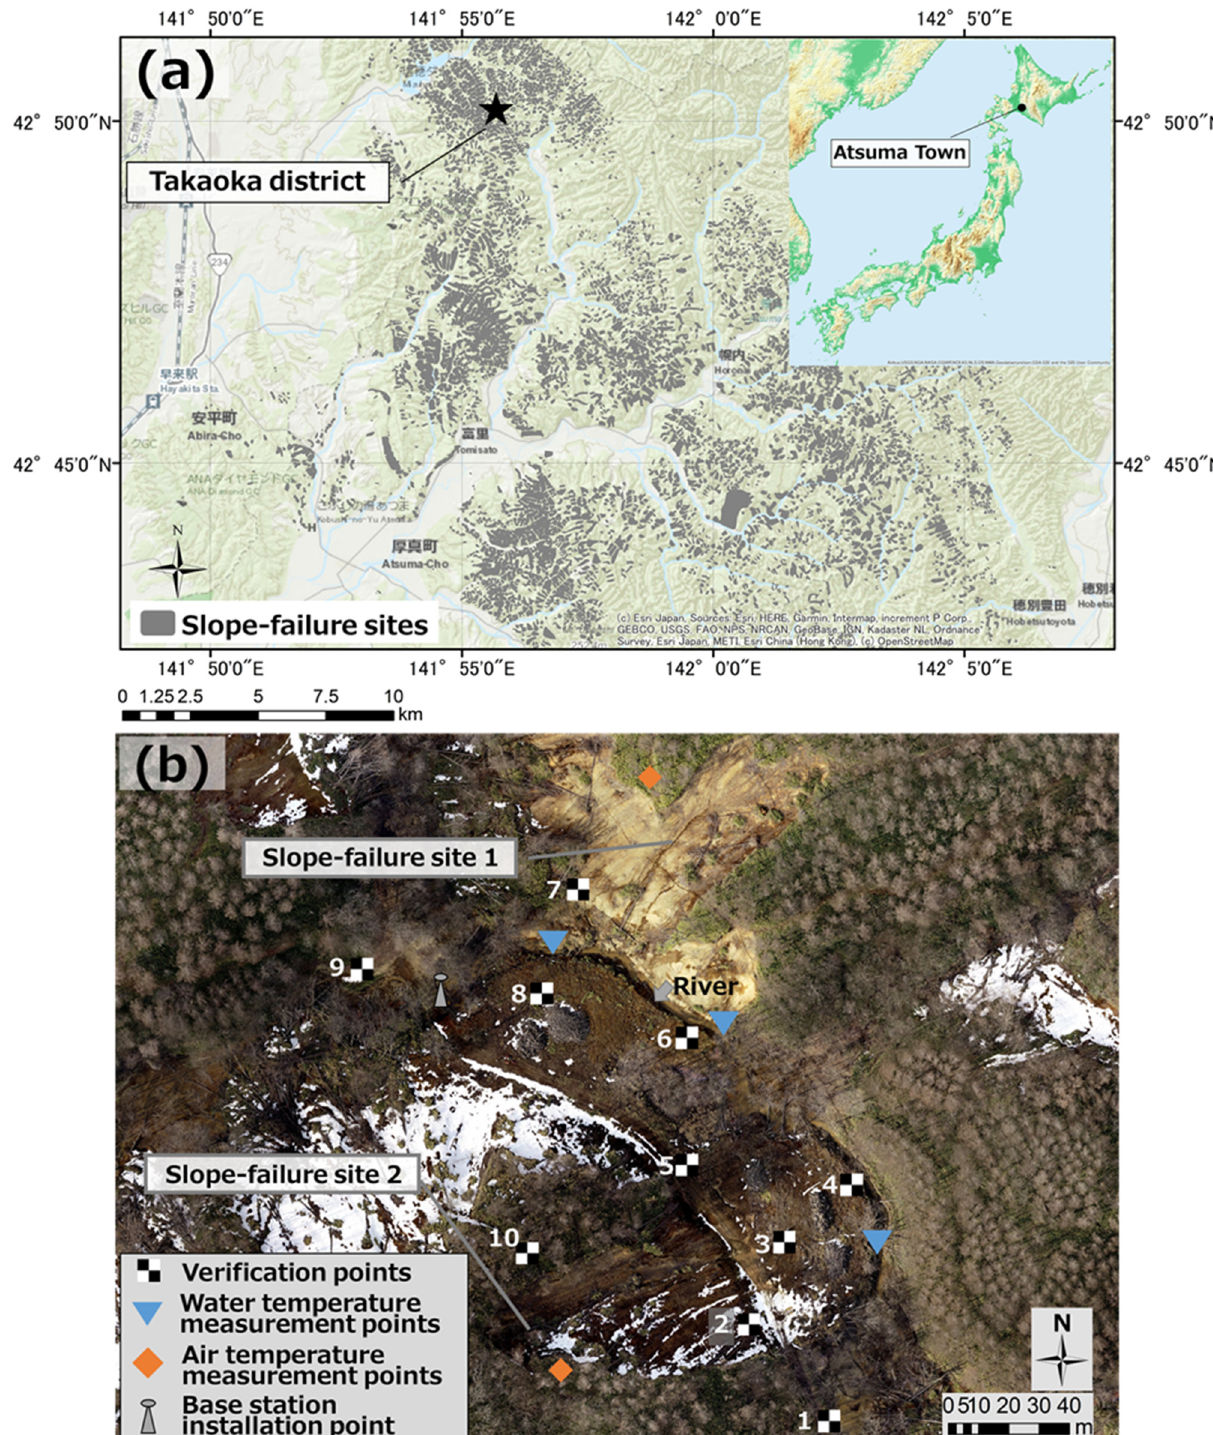
Figure 1. ( a ) Location of Atsuma Town and Takaoka District within the study area. ( b ) Locations of the slope-failure sites, verification points, water temperature measurement points, and air temperature measurement points.